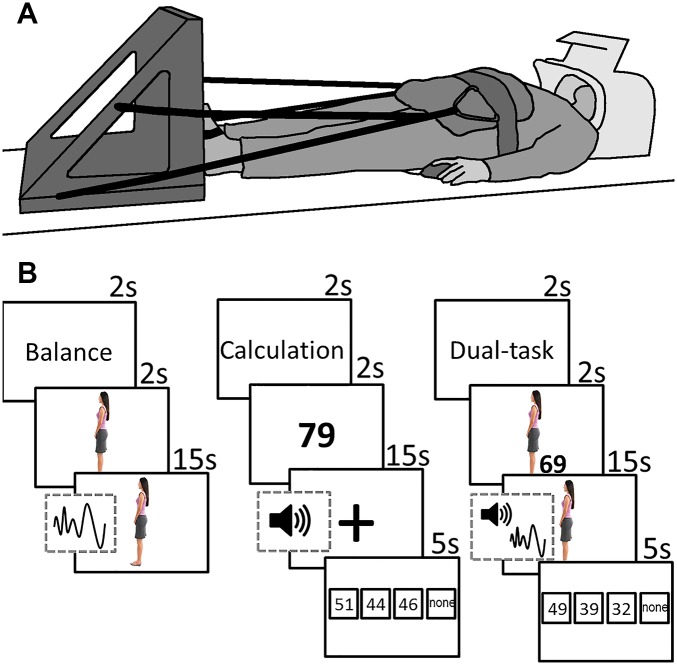
A: Illustration of experimental setup in the scanner. Participant lies supine with her feet against the force platform. B: Schematic of the stimuli during balance, calculation and dual-task conditions. The sine wave signifies the addition of the disturbance signal, causing the avatar to sway forward and backward. The speaker signifies the addition of beeps, which indicated the time points at which the participant had to subtract.